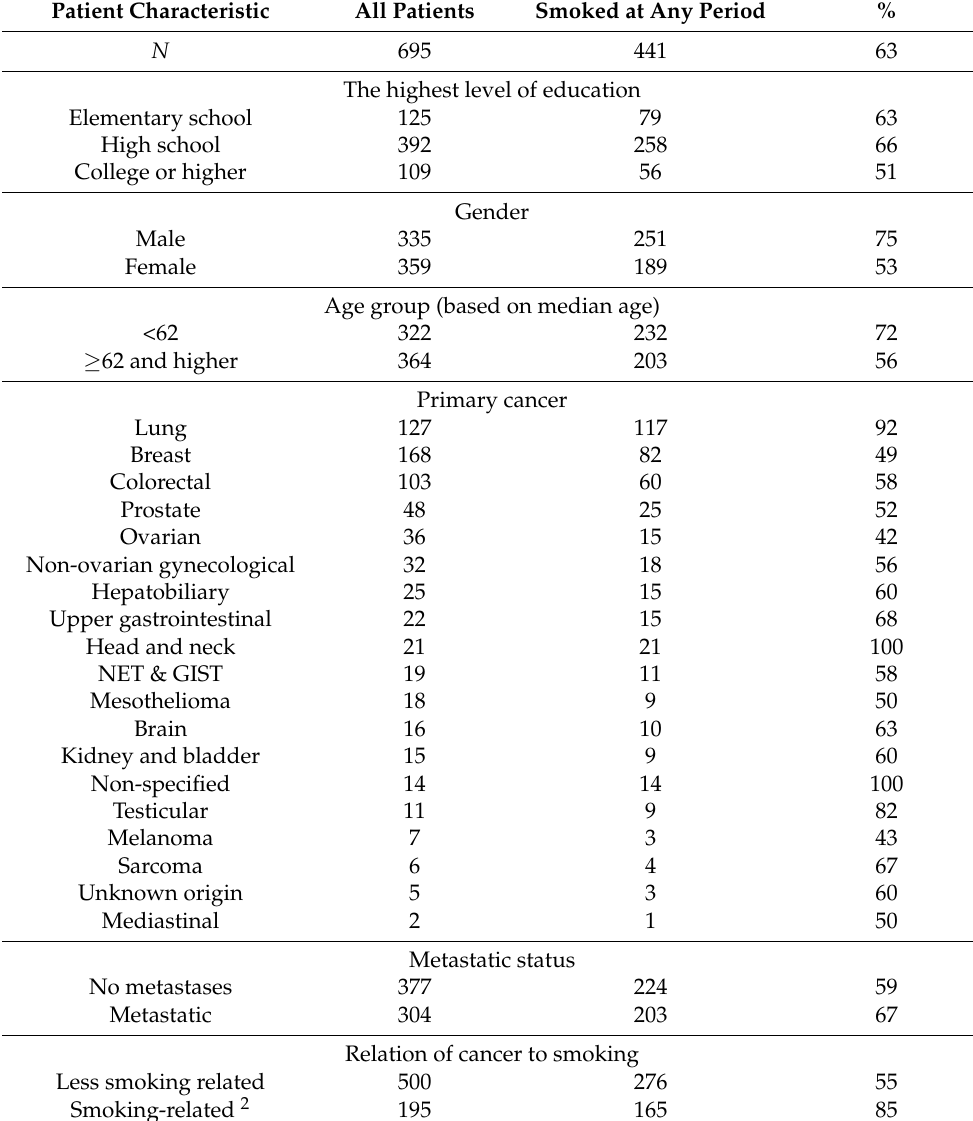
Table 1. General information on the patients who completed the questionnaire ( N = 695) 1